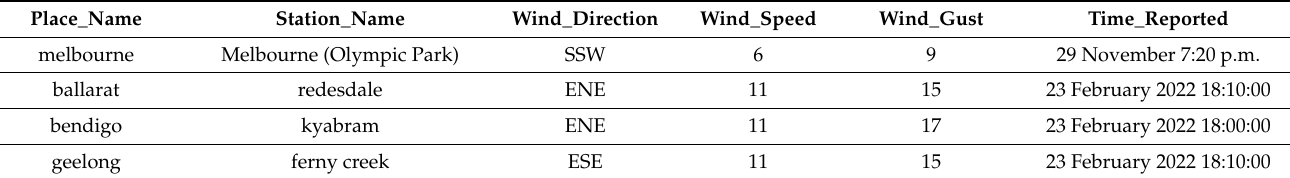
Table 6. Weather observations from automatic weather stations in Victoria.